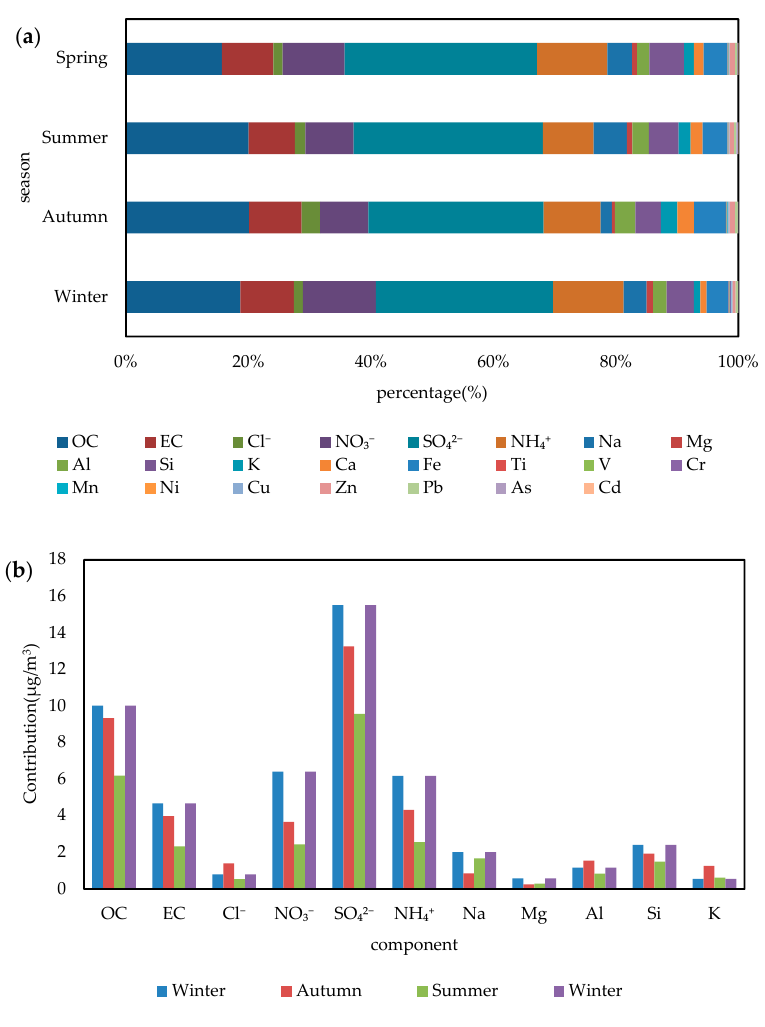
Figure 6. PM 2.5 compositions in di ff erent seasons. ( a ) The percentage of 23 components of PM 2.5 in di ff erent seasons. ( b ) PM 2.5 main component concentration in di ff erent seasons ( µ g / m 3 ).